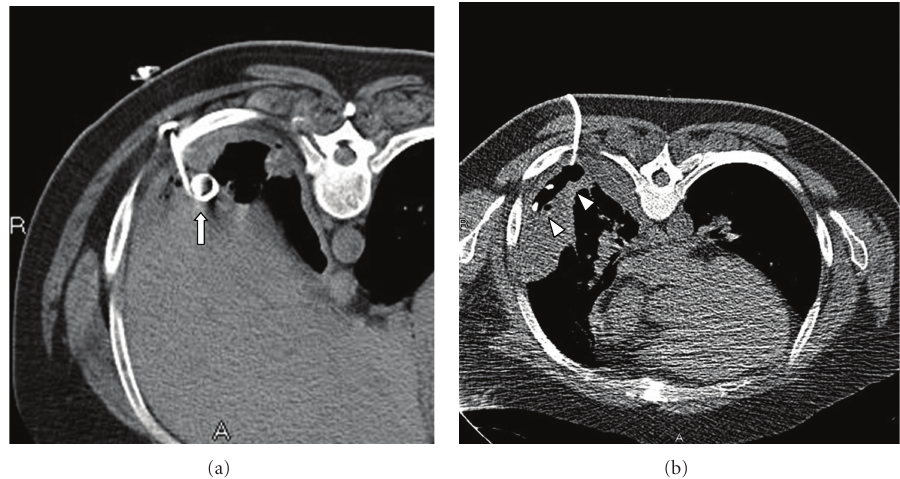
Figure 2: CT images after chest tube drainage. (a) Image shows placement of pigtail catheter (arrow) in the posterior recess confirmed with CT. (b) Placement of small-bore pigtail catheter (arrowheads) in the small loculated e ff usion with the help of CT guidance.